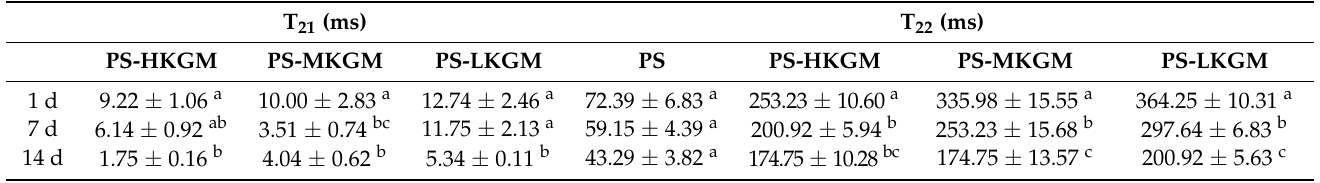
Table 1. The relaxation time (T 2 ) of PS—KGM mixtures at different storage times. T 21 (ms)